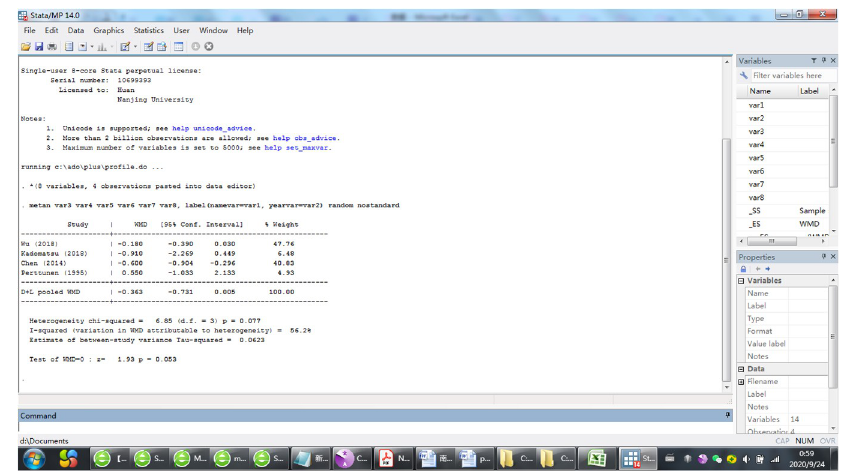
Fig 10. Comparison: PVB vs INB. Outcome: VAS at rest at the first 24 h.